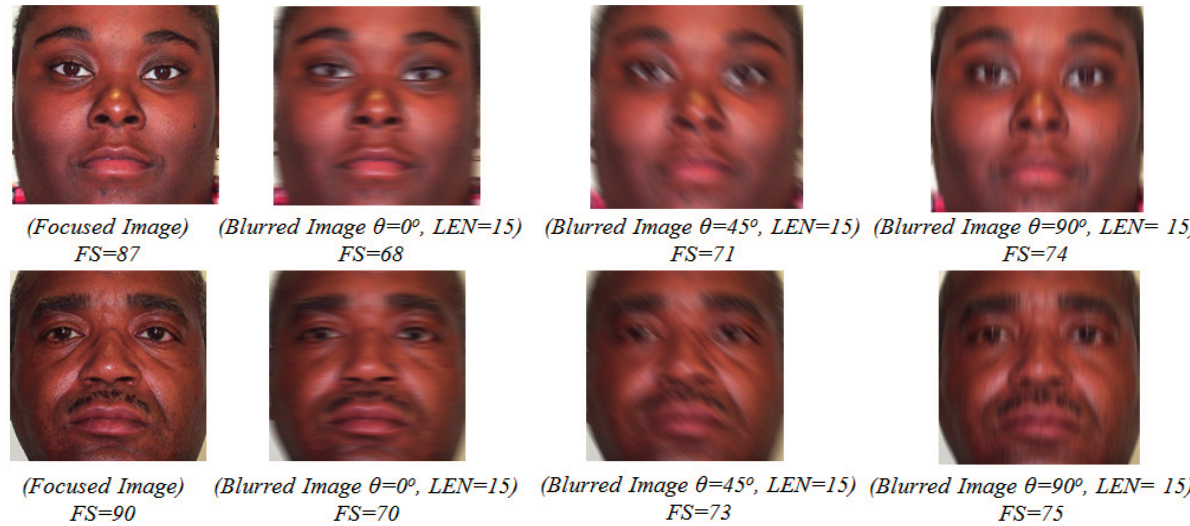
Figure 11. Example of focus score measurements using our method with focused image and corresponding motion-blurred images ( θ is motion direction; LEN is amount (length) of motion blur).